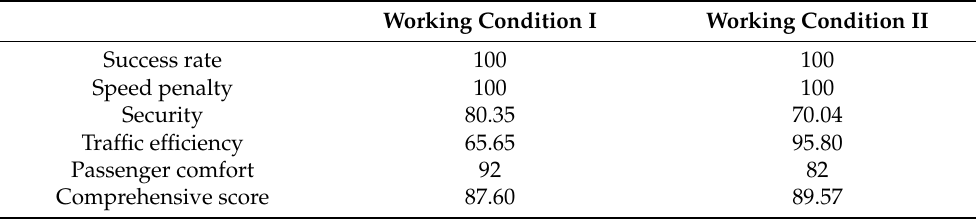
Table 6. Comparison of results for decision-control model under two driving